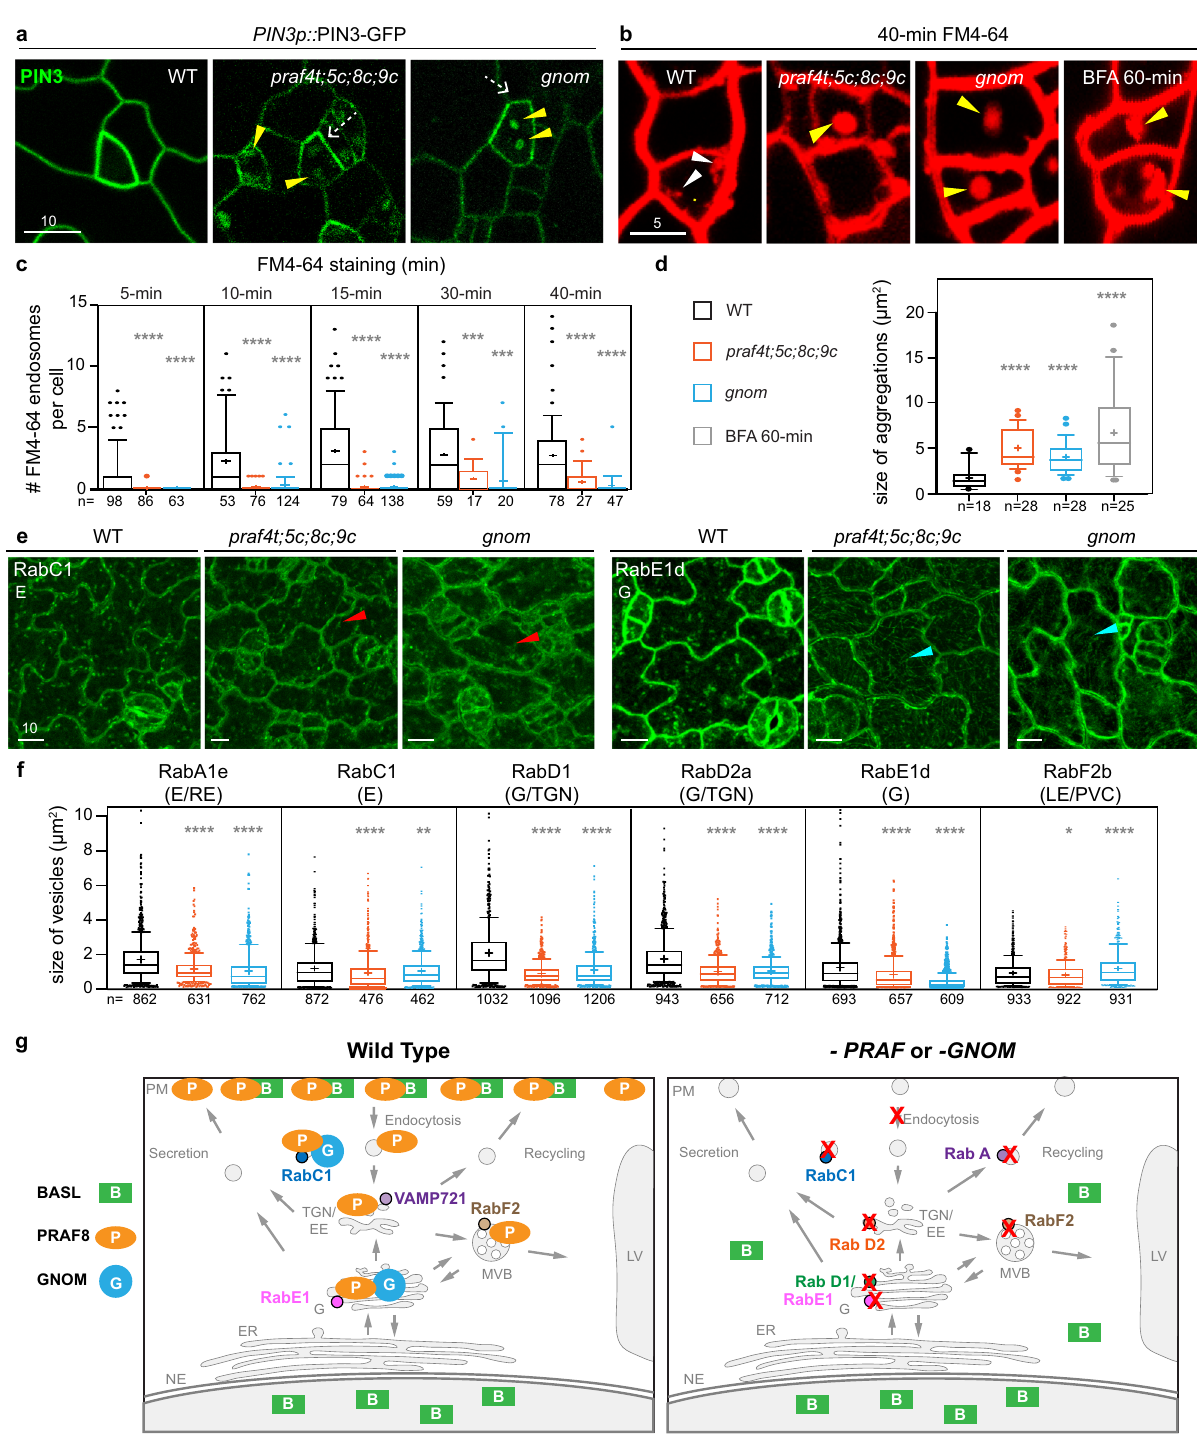
observation of abnormal morphogenesis and distribution of RabE1d and other organelle markers in both gnom and praf mutants (Fig. 7e and Supplementary Fig. 11c). Surprisingly, we did not detect a signi fi cant connection between RabA GTPases (RabA1e and RabA5d) and PRAF proteins (Supplementary Figs. 6 and 10b). The RabA GTPases are the homologs of Rab11 in animals 48,75 that function in secretion and endocytic recycling of PM proteins 45,65,76 – 79 . The Arabidopsis genome encodes an expanded RabA group comprising 26 members 80 . The possible functional connection between PRAF and RabA